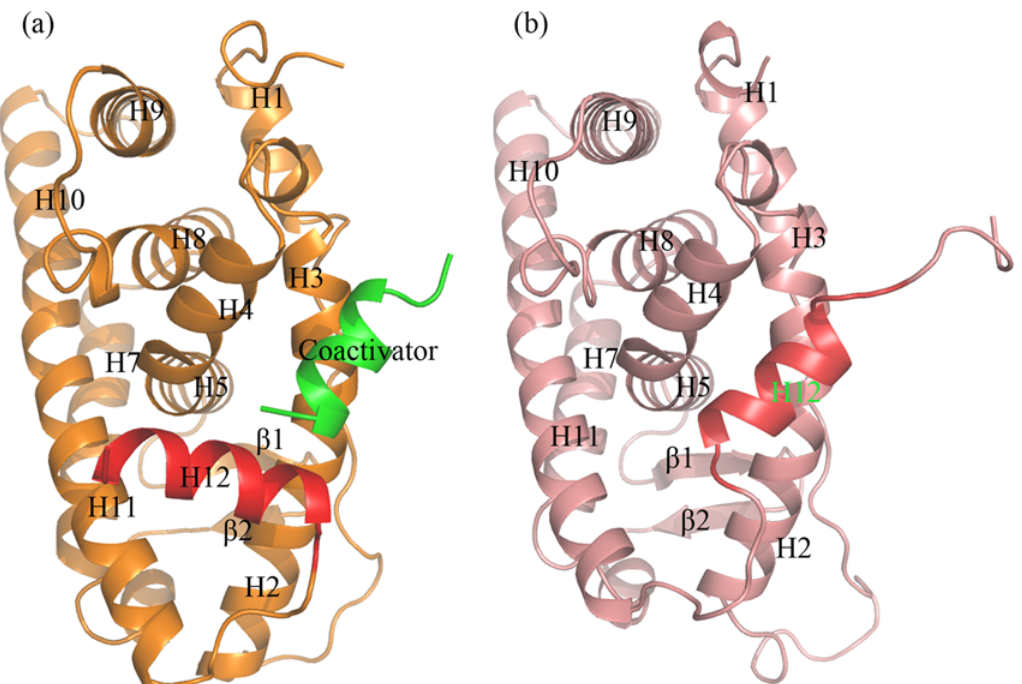
Fig 5. Cartoon representations of the active and inactive conformation of hER α . a) The active state of the protein with H12 in red cartoon and coactivator in green cartoon; b) The inactive state of the protein with H12 (red) covered the shallow groove which would be occupied by the coactivator.